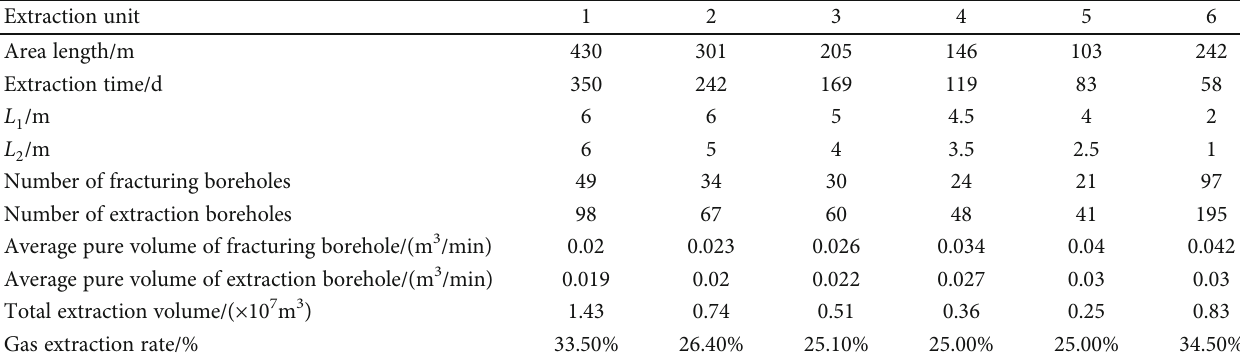
Figure 11: Design drawing of gas extraction borehole along the working face of 3307. Table 3: Gas drainage e ff ect of each extraction unit in working face